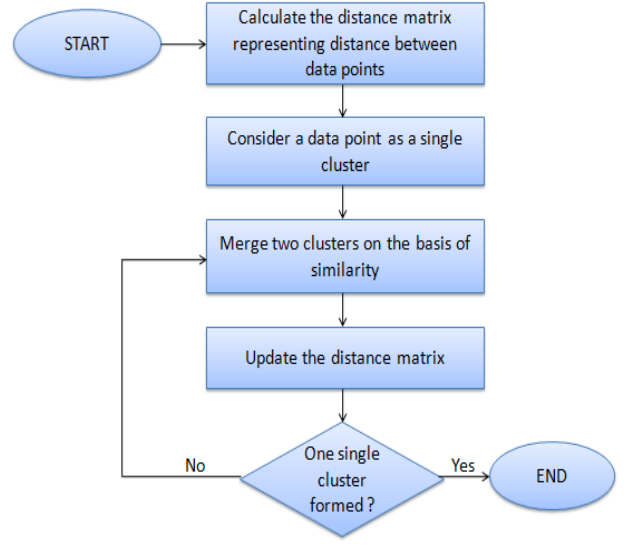
Fig. 8. Agglomerative hierarchical clustering